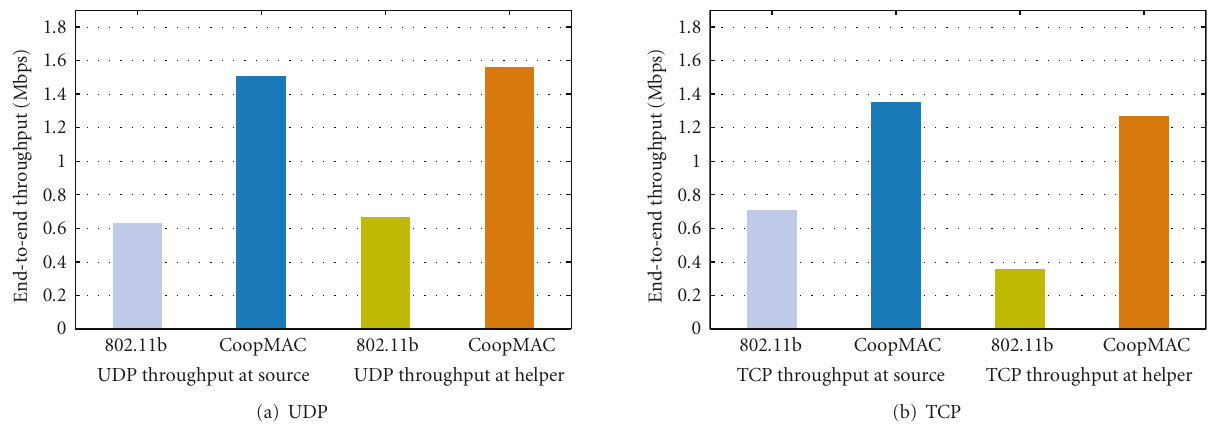
Figure 7: Throughput comparison: active tra ffi c from helper.